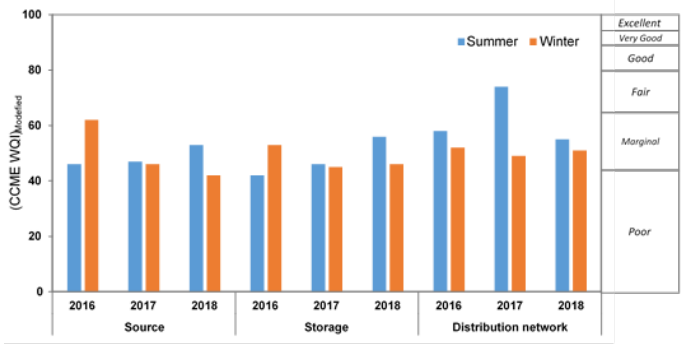
Figure 5. Modified CCME WQI in WSS-II (Zone 3).